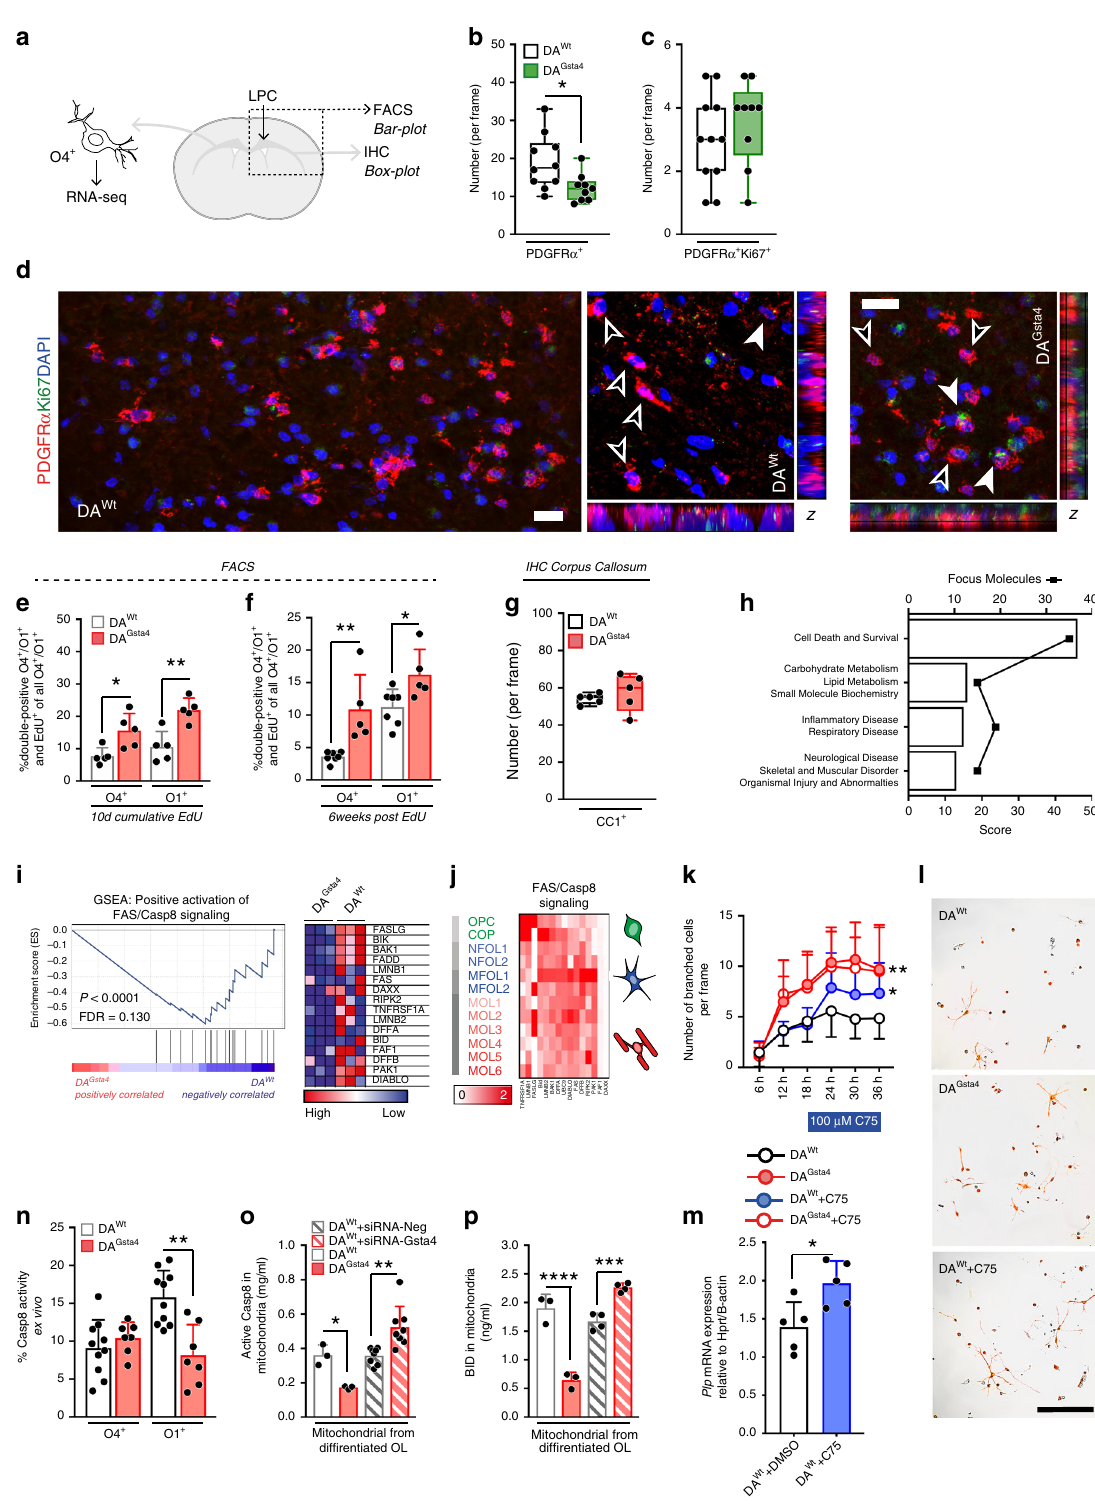
(Fig. 2g, h and Supplementary Fig. 1c). These observations strengthen the notion that Gsta4 regulates differentiation of rat OPCs while exerting context-dependent effects on their proliferation. Gsta4 accelerates the passage of OPCs to OLs via Casp8-Bid . The effects of Gsta4 on the OL lineage were further evaluated in